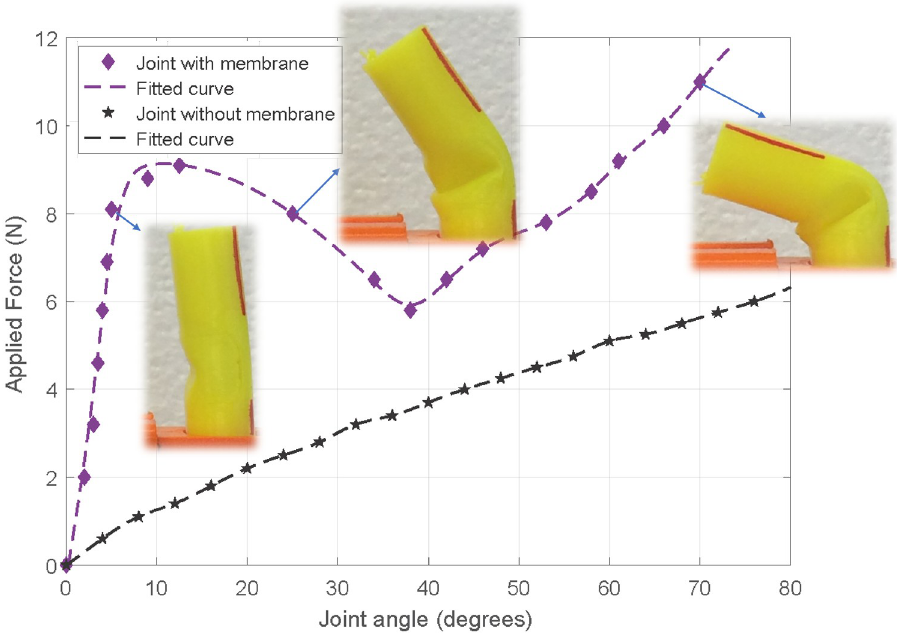
Fig 12. Experimental results of flexural stiffness of the flexure joints with and without